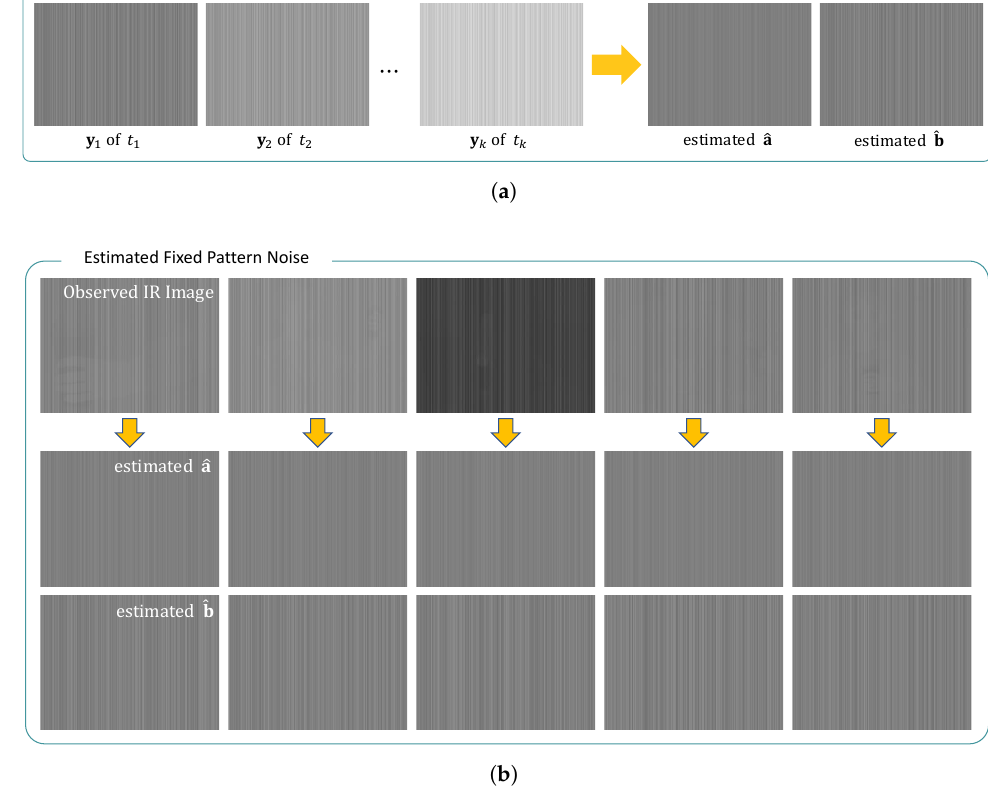
Figure 3. Materials of the proposed fixed pattern noise estimation algorithm. ( a ) Framework of the proposed FPN estimation algorithm using calibration data; ( b ) estimated FPN components of the proposed algorithm for five different infrared